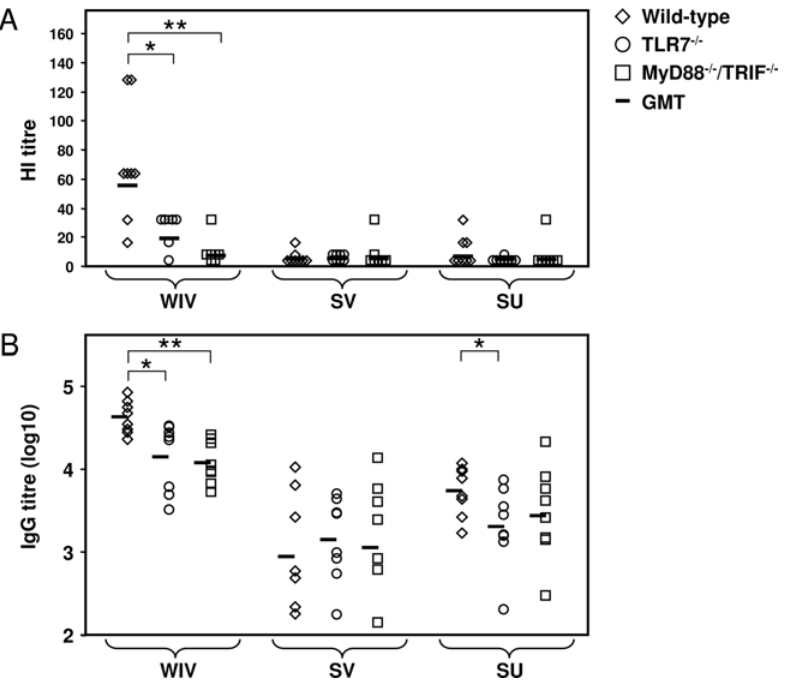
Figure 1. TLRs contribute to the efficacy of H5N1 WIV vaccine. Four weeks after immunization of wild-type, TLR7 2 / 2 , and MyD88 2 / 2 /TRIF 2 / 2 mice with WIV, SV, or SU vaccine (5 m g HA), serum HI titres (A) and H5N1-specific IgG titres (B) were determined for the individual mice. Titres below the detection limit were assigned with half the value of the lowest detectable serum dilution, which was 8 in the HI assay and 100 in the IgG ELISA. Significant ( p , 0.05) and highly significant ( p , 0.01) differences between wild-type mice and mutant mice receiving the same vaccine are indicated by * and **, respectively. GMT indicates geometric mean titter.